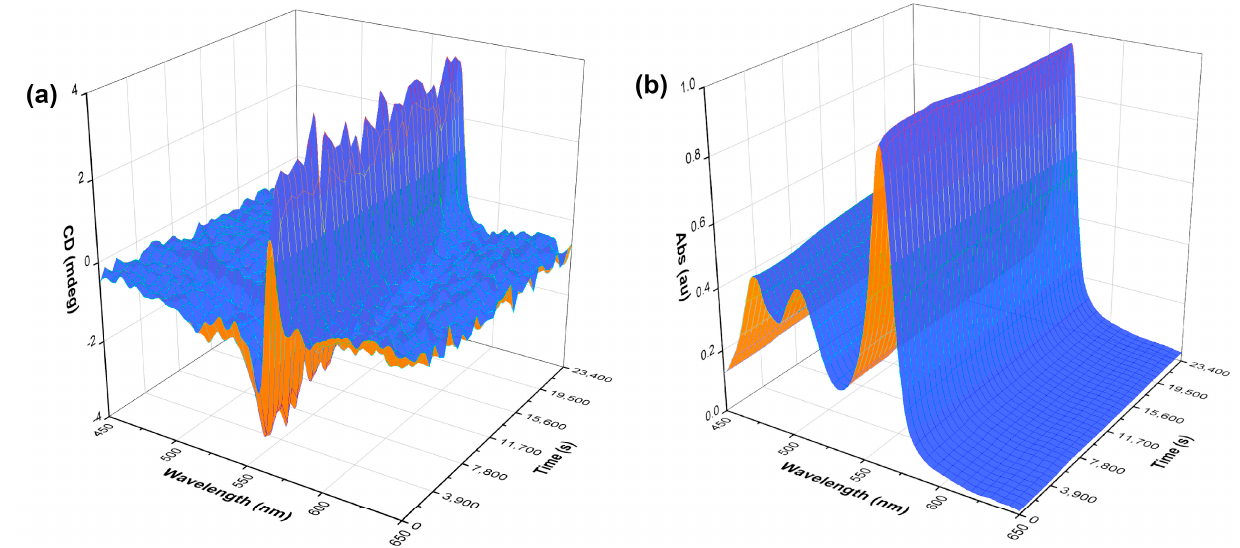
Figure 4. A three-dimensional kinetics plot of S0271 at 40 µM in Milli-Q water (pH 7.12, 18.2 Ω cm − 1 ) stirred CW in situ in the CD spectrometer. ( a ) CD kinetics spectra and ( b ) UV-vis kinetics spectra. The measurements were taken across 6.5 h taking a measurement every 10 min, recorded at 21 °C.